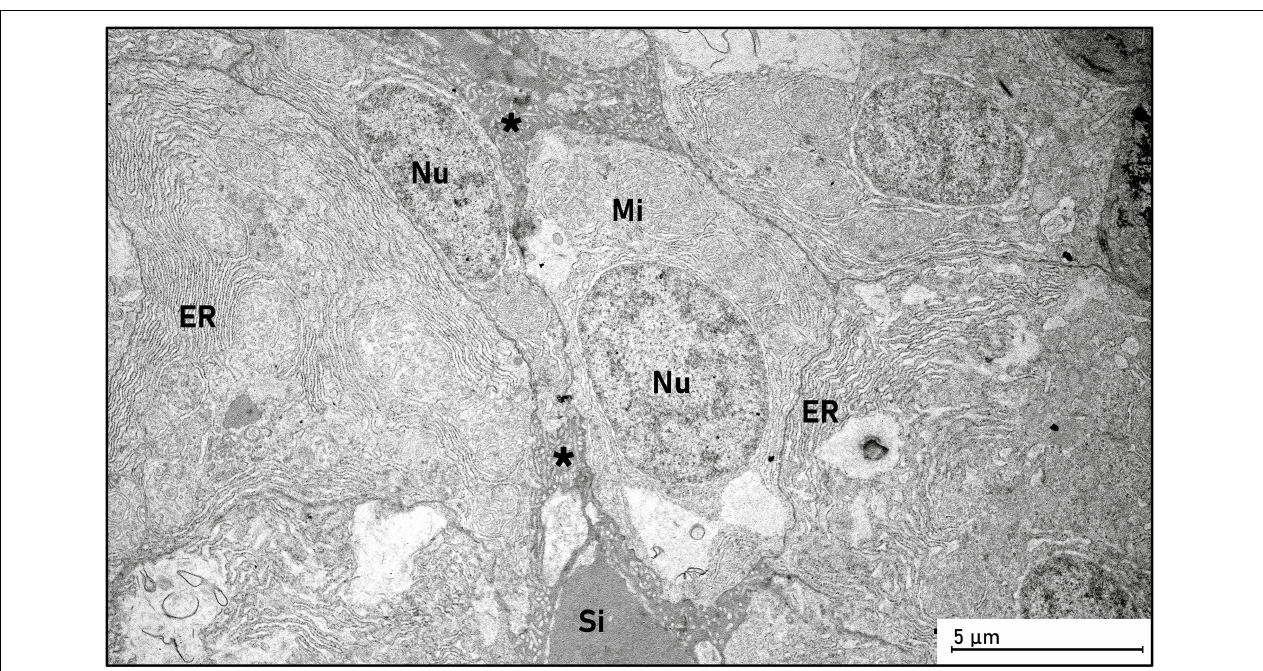
FIGURE 8 | Transmission electron micrograph of the liver in a European eel leptocephalus larva ( Anguilla anguilla ). The hepatocytes were characterized by a nucleus (Nu), numerous mitochondria (Mi), dense structures of smooth and rough endoplasmic reticulum (ER), and the perisinusoidal space (space of Disse; *) was observed between the hepatocytes and a sinusoid (Si). Abbreviations: *, space of Disse; ER, endoplasmic reticulum; Mi, mitochondria; Si,